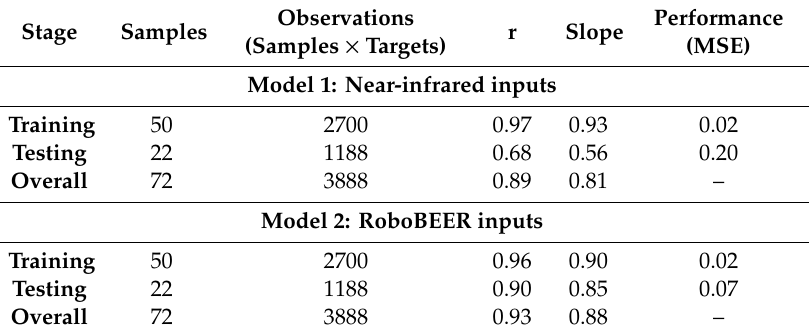
Table 3. Statistical results from the two machine learning models.